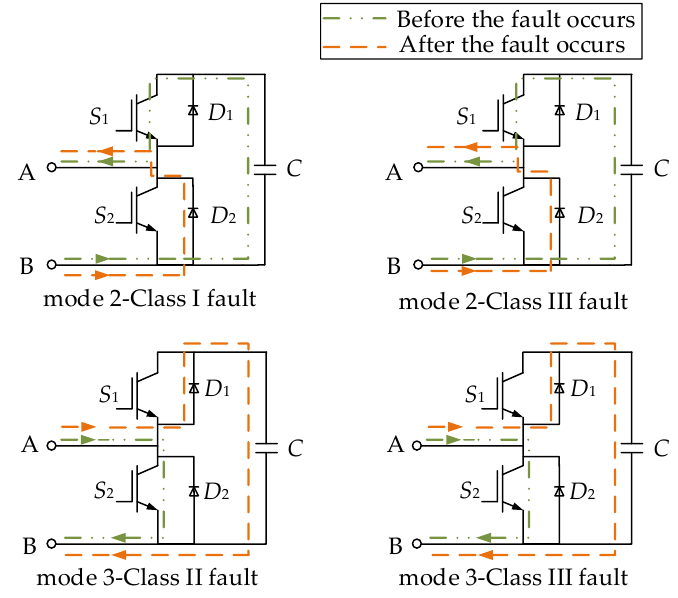
Figure 3. Open-circuit fault analysis of submodule.